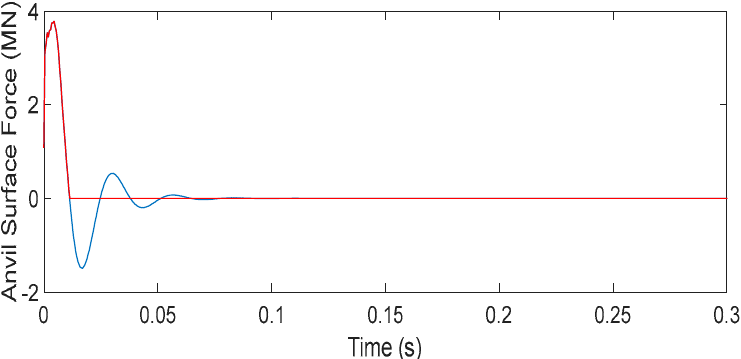
Figure 4. Free vibration (blue line) and truncated force (red line) applied at the anvil surface. The truncated anvil surface force is then converted back to the frequency domain, and Equation (17) is recalculated, taking into account this force instead of the momentum m r v 0 . Therefore, new displacements for the ram ( u r ) and the anvil ( u a ) are calculated. Afterwards, it is possible to compute the pile head force F p in the frequency domain through the following equation: After computing the load applied to the pile head, the dynamic response of the system is obtained in the frequency domain by multiplying the transfer function, which is computed through the axisymmetric FEM-PML approach by the loading function F p . The results in the time domain are then obtained by an inverse Fourier transform